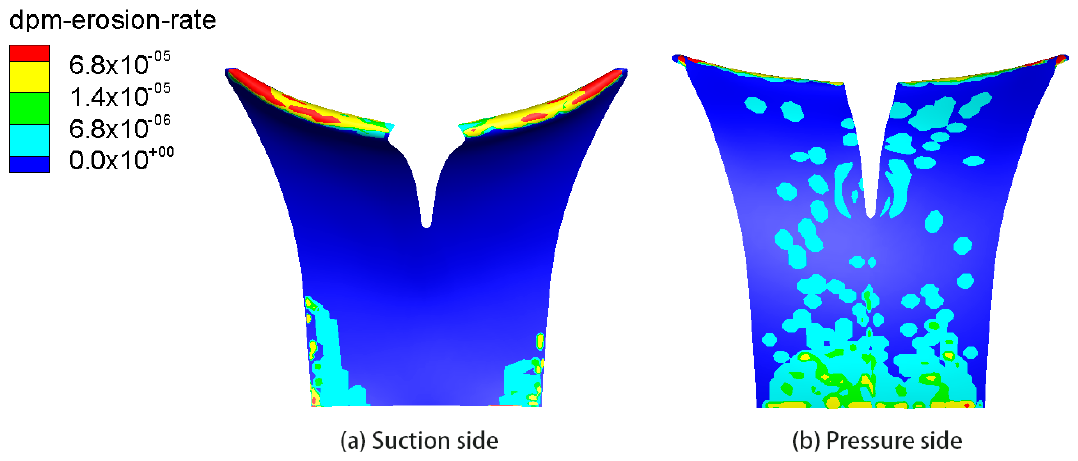
Figure 13. Silt erosion on blade surface (units: μ m/s, silt concentration: 2.0 kg/m 3 ).